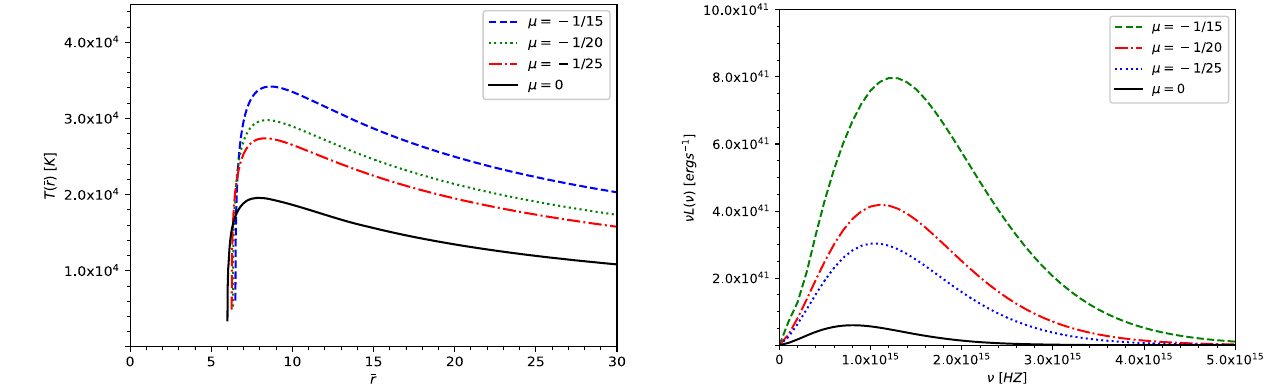
Fig. 3 Variety of the disk temperature T ( ¯ r ) with negative parameters μ for the thin disk around a BH in EACT